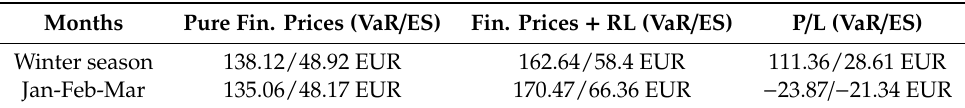
Table 7 summarizes the pure financial prices (column 2), the full prices (i.e., adding risk loadings—column 3) and profit and losses (column 4) for HDD in the winter 2017 season. Table 7. Comparison between HDDs pure financial prices, financial prices + risk loadings (RL) and Profit and Loss (P / L) − winter season 2017.